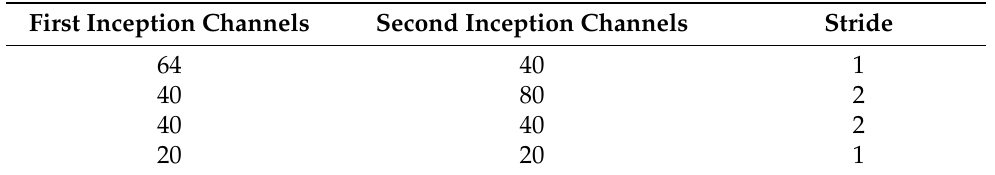
Table 1. The structure of our proposed hybrid parallel network.